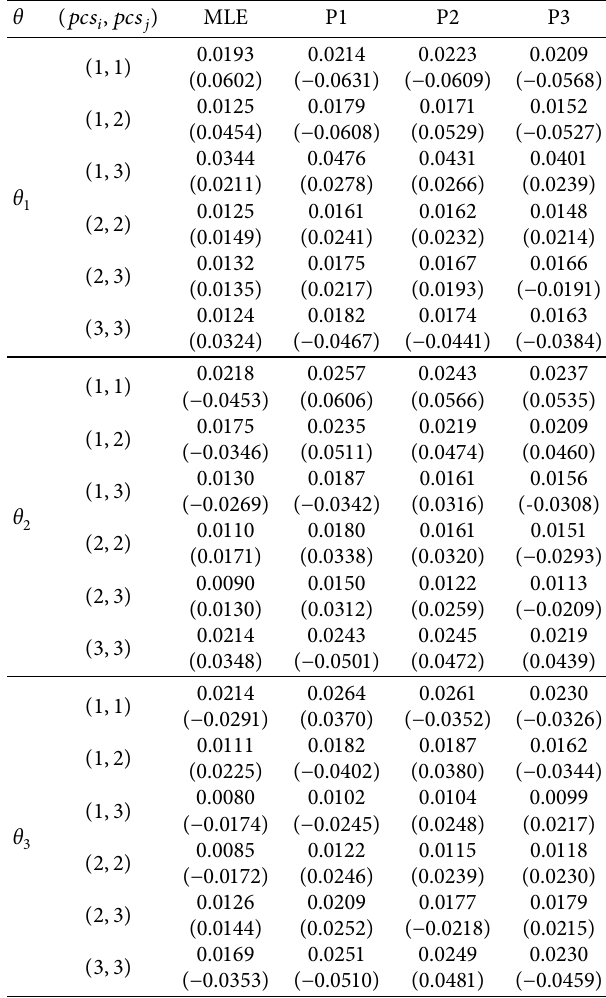
Table 2: The MSE (bias) for the estimators of R with unknown σ